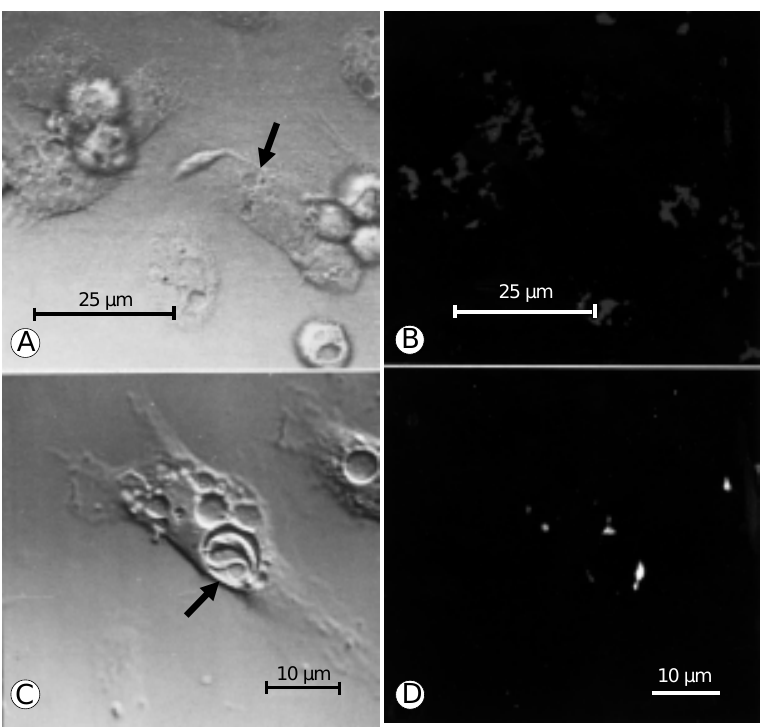
Figure 5 - Labeling of the cell with DTAF and observation by differential interference microscopy (A,C) and CLSM (B,D) following interaction with epimastigote (A,B) and trypo- mastigote (C,D) forms of Trypanosoma cruzi . In the case of attached epimastigotes, labeling of the attachment region is observed (arrow in A). Labeling of the vacuole contain- ing internalized trypomastigotes was observed (arrow in C). A , B : Bar = 25 µm; C , D : Bar = 10 µm.